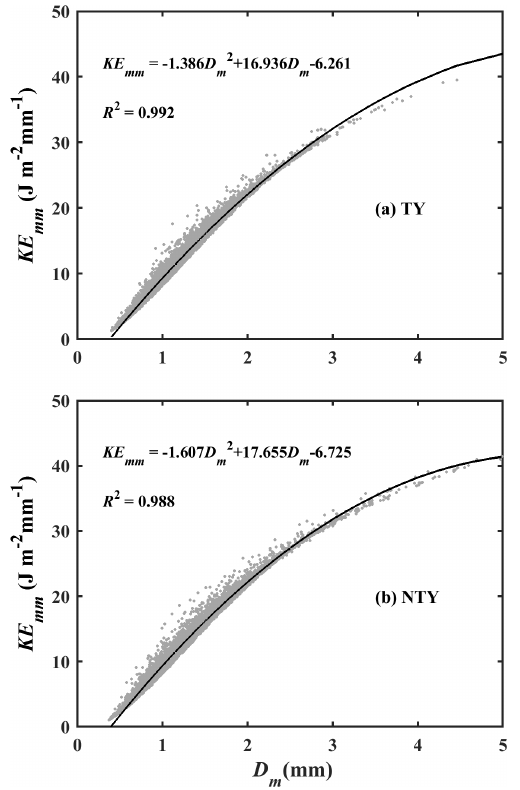
Figure 12. Scatterplots of volume-specific KE (KE mm in Jm − 2 mm − 1 ) with D m (mm) for typhoon (TY) and non- typhoon (NTY) rainfall.